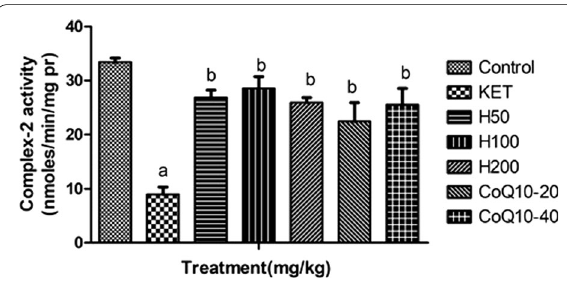
Fig. 11 Effect of hesperidin and Coenzyme Q10 on complex I enzyme activity in the prefrontal cortex region of the brain. Data were analyzed by one-way ANOVA followed by Tukey’s post hoc analysis.